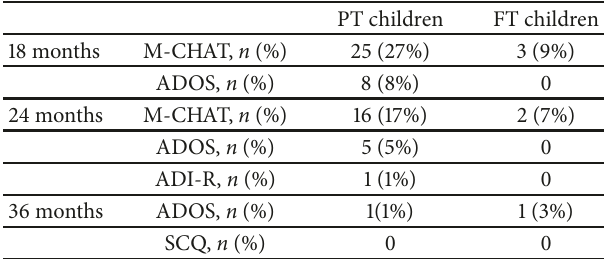
Table 2: Autism spectrum disorder risk among preterm and full- term children